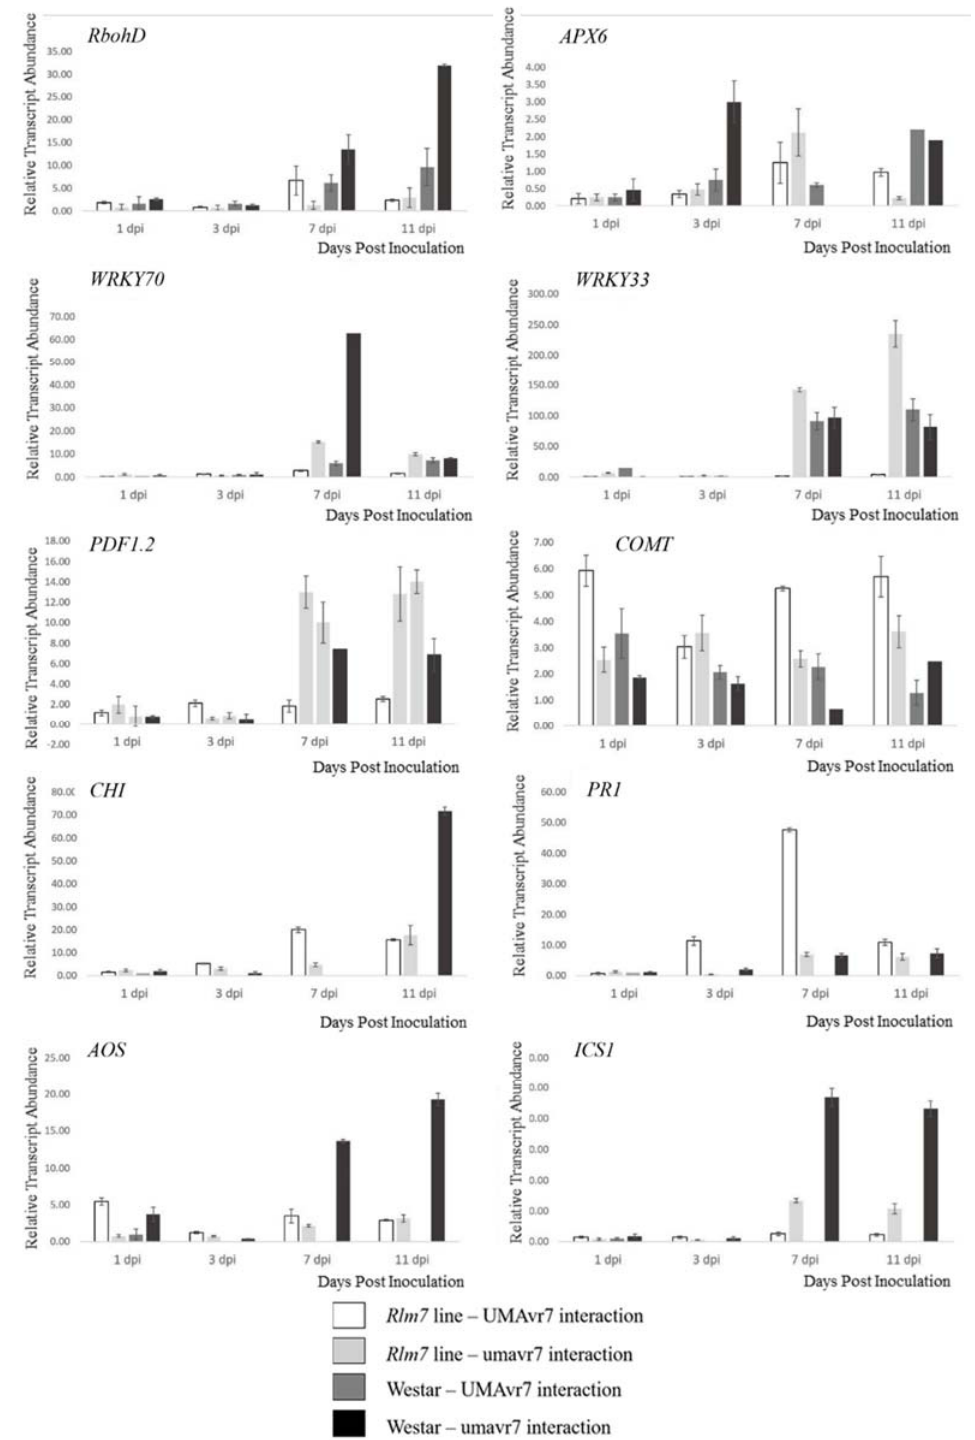
Figure 13. Brassica napus gene expressions followed by inoculation with Leptosphaeria maculans . Relative transcript abundance of RBOHD, APX6, WRKY70, WRKY33, PDF1.2, COMT, CHI, PR1, AOS and ICS1 in susceptible (S) and resistant (R) cotyledons assessed at 1-, 3-, 7-, and 11-dpi. The interactions of Westar with both isolates have also been analyzed. Actin (GenBank accession number AF111812.1) was used as the internal control and to normalize expression data. Relative transcript abundance is normalized relative to 0-dpi in each treatment. Error bars represent standard deviation of the mean. The results are based on three replicates in three independent